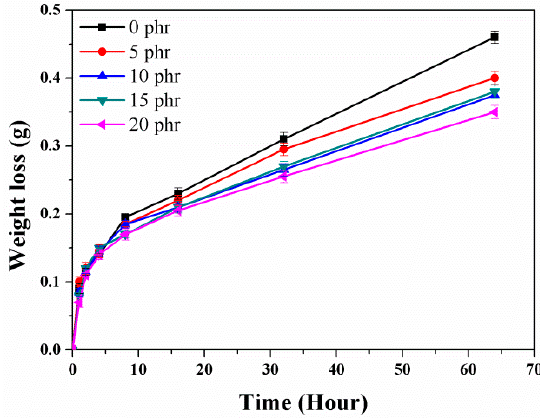
Figure 4. Triacetin-permeation in EPDM/CR nanorubbers with various layered-silicate contents.